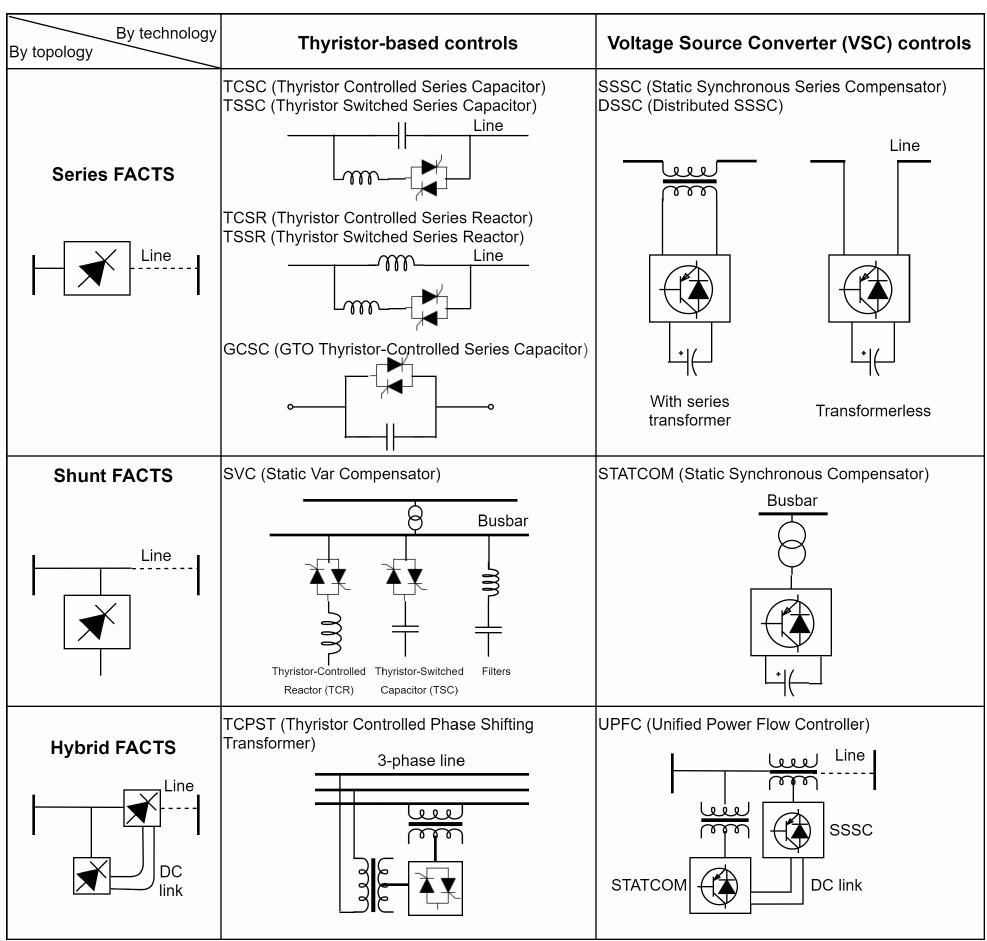
Figure 1. Flexible AC Transmission System (FACTS) classification by topology and